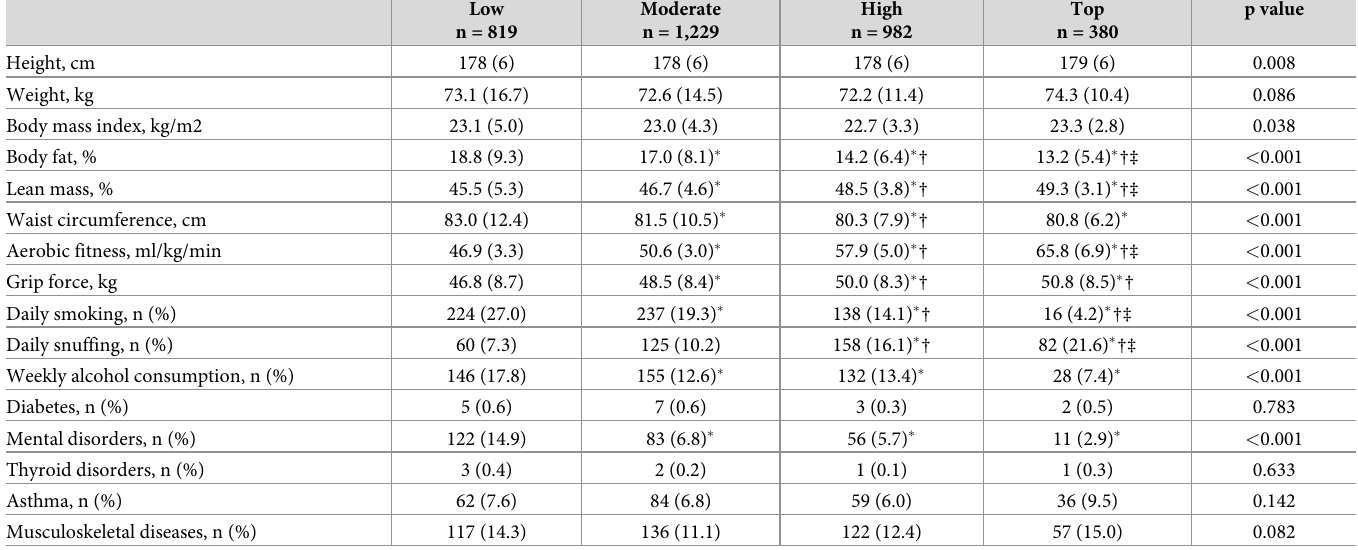
Table 1. The characteristics of the study participants (n = 3,395) according to reported physical activity level. Values are presented as means (SD) unless otherwise